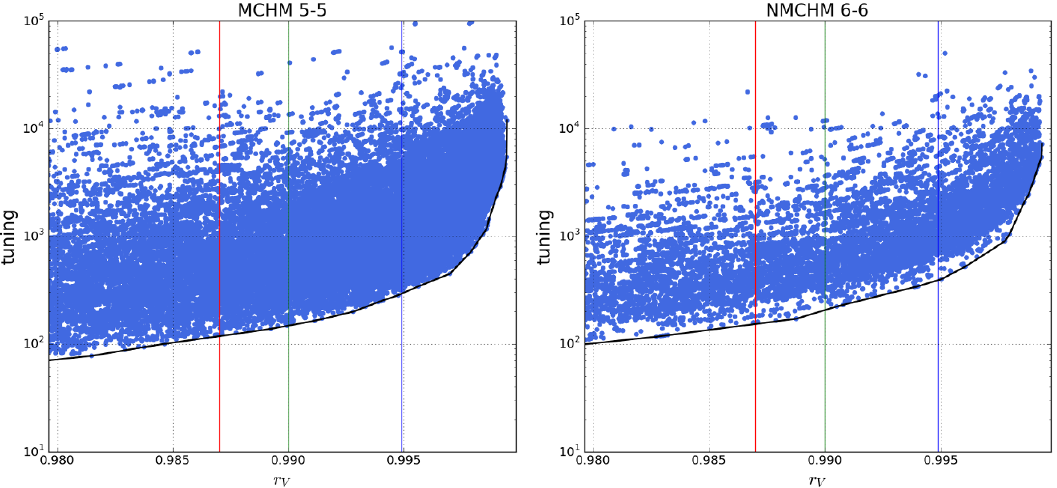
Figure 7. Comparison of higher-order tuning in the Higgs-vector boson coupling deviation, between the minimal and next-to-minimal models. The red line shows the expected precision of a 250 GeV ILC, green a 500 GeV ILC, and blue a high-luminosity 1 TeV ILC.